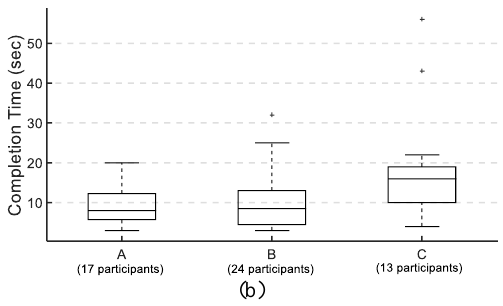
Figure 7. Variation of task completion times for map-based approach (a) and AR-based approach (b) at different data collection